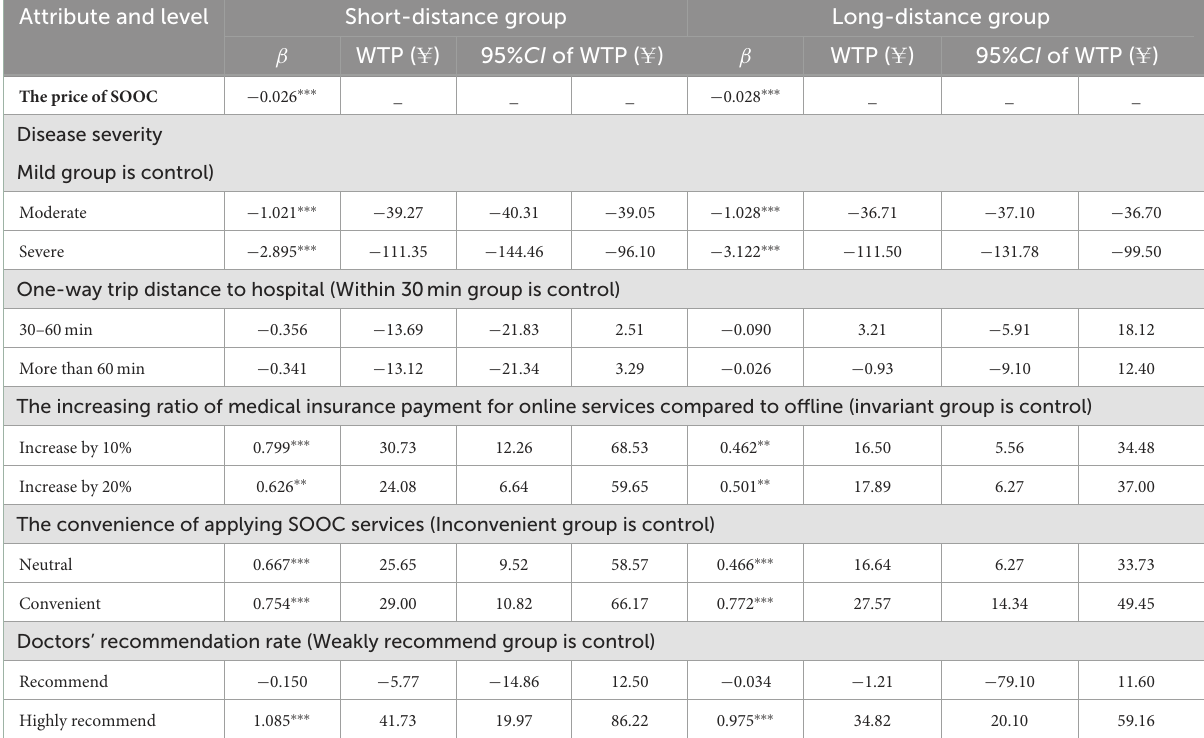
TABLE 10 Conditional logit regression analysis and the WTP of patients with different distance. Attribute and